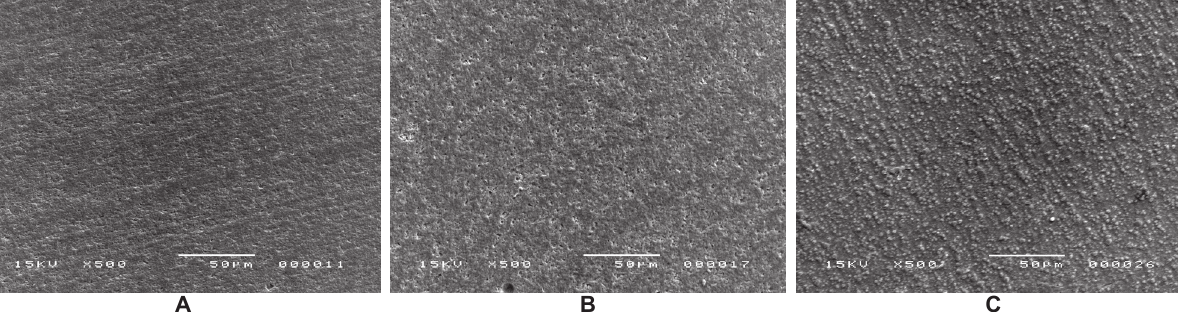
Figure 2- Qualitative analyzis of different composite resins after abrasion test. A - Nanofilled (Esthet X); B – Nanohybrid (TPH3); C – Microhybrid